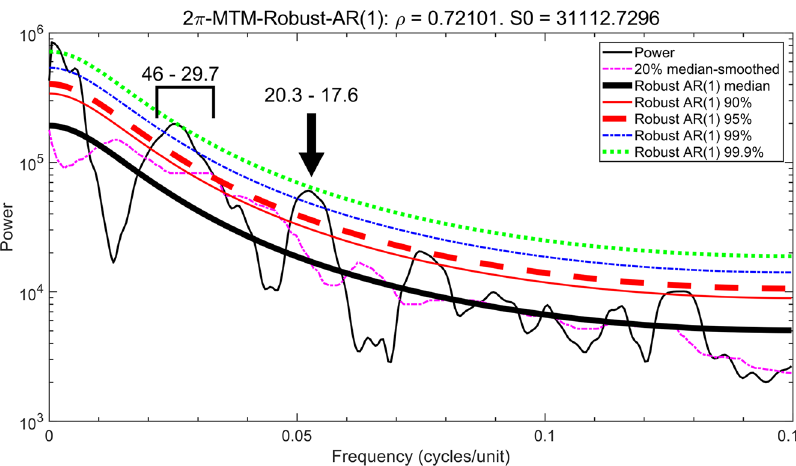
Fig. 4 Multi-taper (MTM; 2 π ) power spectrum of the macrocharcoal record ((Si + Ti + Al + Fe) XRF /Ca XRF normalized) in time domain. This power spectrum was obtained in the Acycle software, with robust red noise models 100 . Dominant peaks are shown at the obliquity (~46 – 29.7 kyr) and precession (~20.3 – 17.6 kyr) frequency bands at 99% signi fi cance. The macrocharcoal record was tuned to the 100 kyr eccentricity of the elemental Ca record spanning the Margaritatus zone (see Supplementary Fig. 1). The Ca record is derived from Ruhl et al. 43